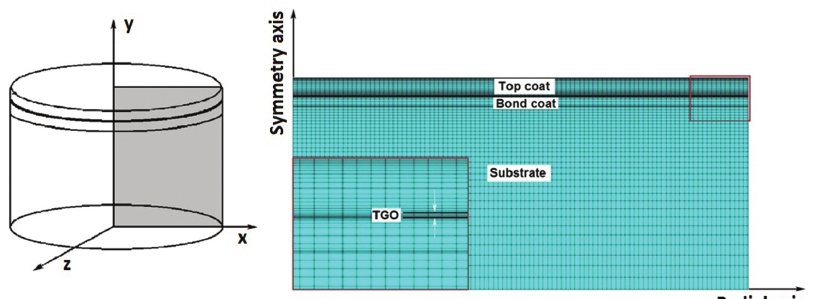
Figure 1: Schematic illustration of geometric